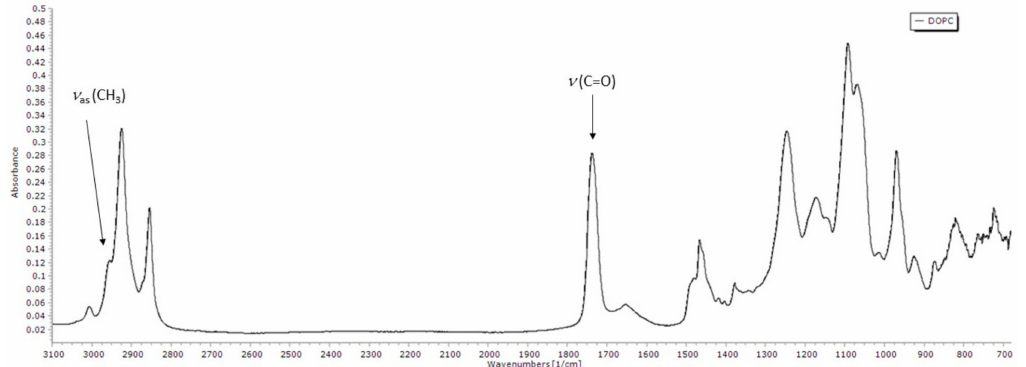
Figure 6. FTIR-ATR spectrum of DOPC with two analyzed bands pointed